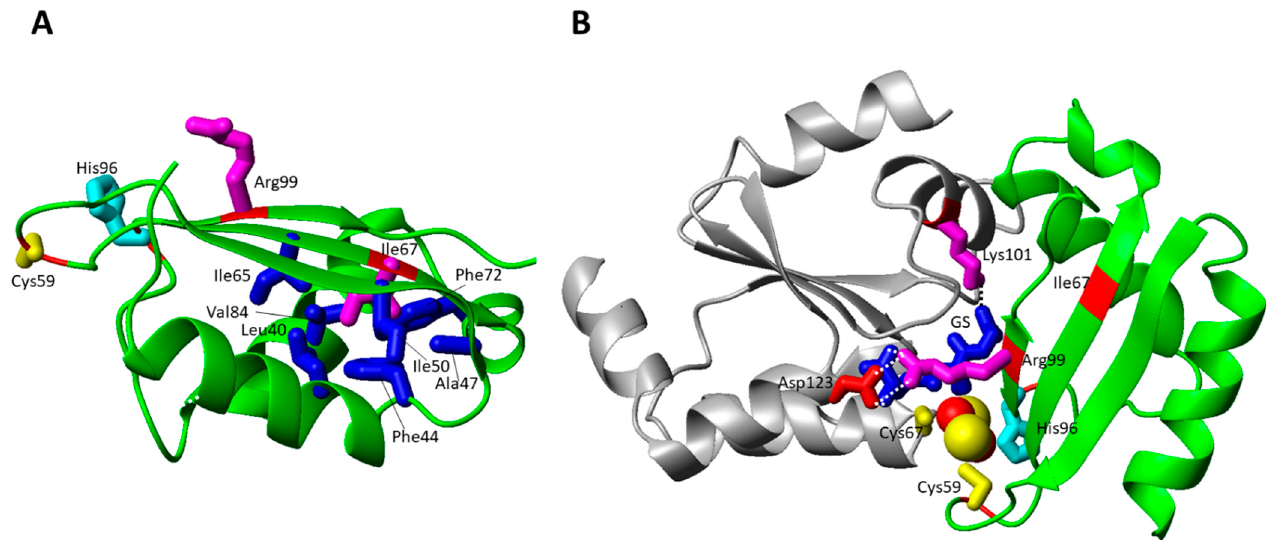
Figure 4. Pathogenic missense mutations mapped on the structures of human BOLA3 and [2Fe- 2S] GLRX5-BOLA3 complex. ( A ) The backbone of the residues involved in pathogenic missense mutations of BOLA3 is colored in red on the solution structure of apo BOLA3 (PDB ID 2NCL), and the sidechains of the conserved cluster coordinating Cys59 and His96 residues are shown in yellow and cyan, respectively. The sidechains of Arg99 and Ile67 residues involved in pathogenic missense mutations are shown in magenta. The sidechains of the hydrophobic residues interacting with Ile67 are shown in blue. ( B ) The ribbon diagram of the structural model of [2Fe-2S] GLRX5-BOLA3 available from a data-driven docking approach [45] is shown. GLRX5 is in grey and BOLA3 is in green. The sidechains of the two Cys ligands and of the His ligand are shown as yellow and cyan stick, respectively; the iron and sulfur atoms of the [2Fe-2S] cluster are in red and yellow spheres, respectively; and GS cluster ligand is shown in blue. The sidechains of the residues involved in pathogenic missense mutations at the interface between BOLA3 and GLRX5 are shown in magenta. Electrostatic interactions involving these residues are shown as dotted